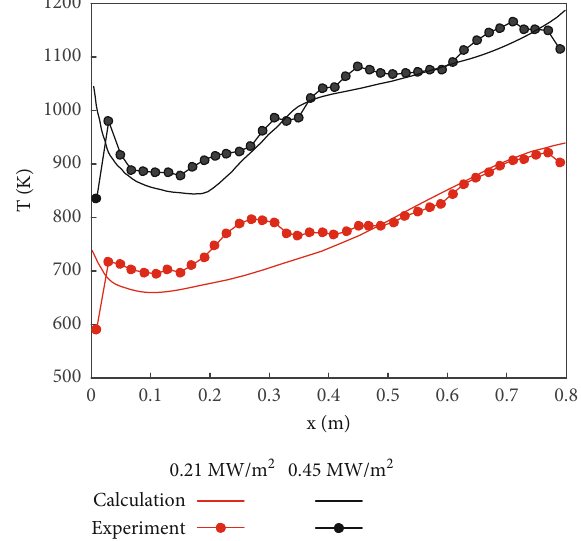
Figure 11: Comparison of computational and experimental results of cooling channel wall temperature.